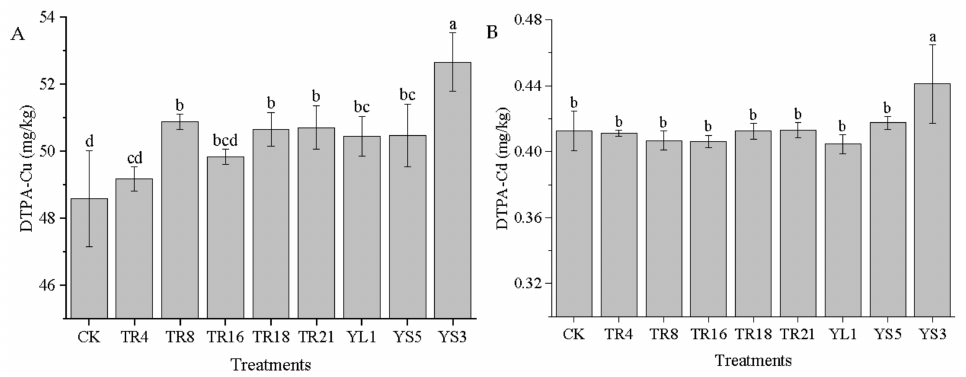
Figure 3. DTPA extractable Cu ( A ) and Cd ( B ) in soil. The different lowercase letters in the figures indicate significant differences ( p <